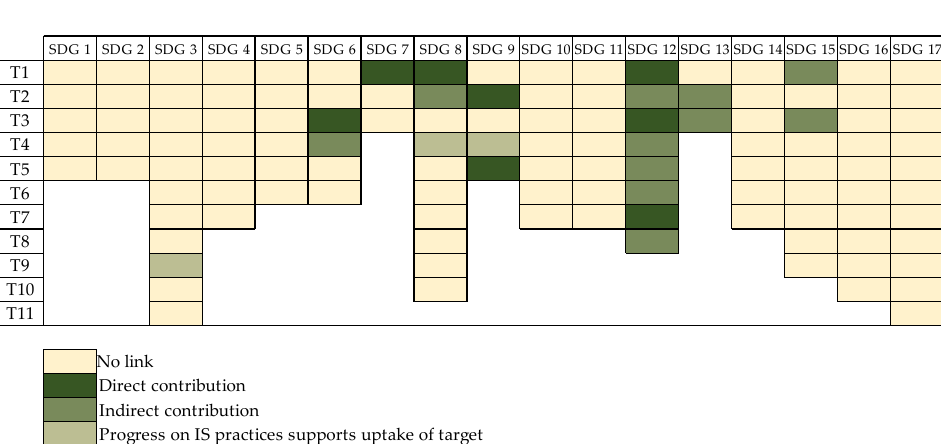
Figure 2. Heat diagram for the matching exercise and target identification